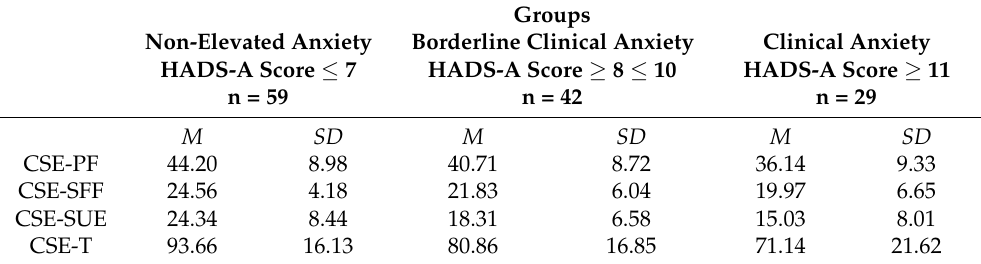
Table 3. Mean scores on the CSE according to anxiety level.